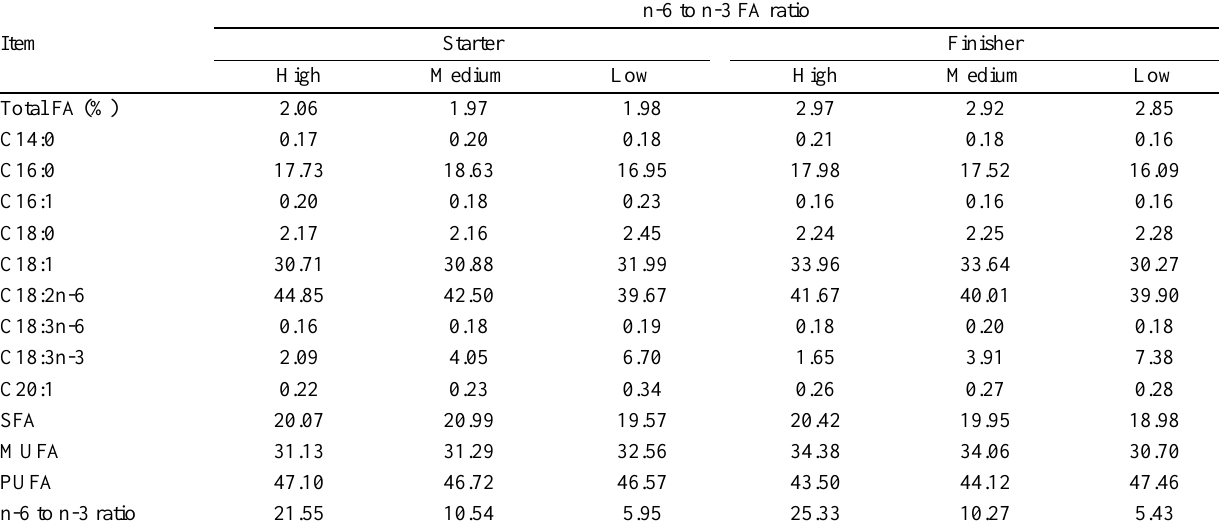
n-6 to n-3 FA ratio